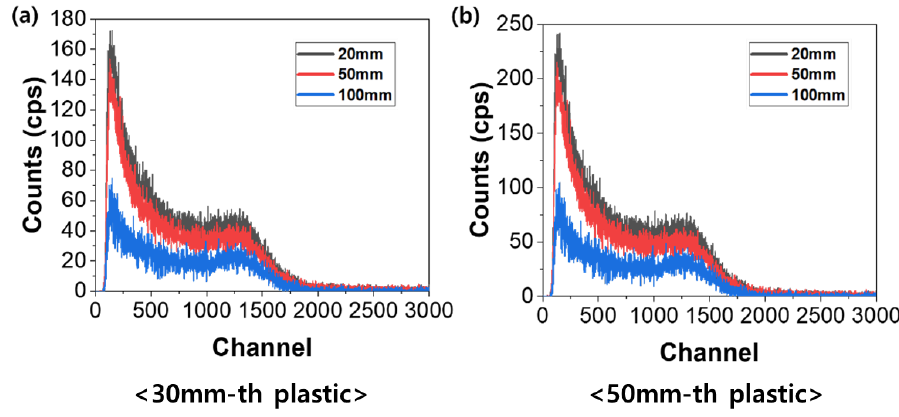
Figure 9. Measurement results due to the distance from the contaminated soil sample using a CdS/ZnS-loaded plastic scintillator: ( a ) 30 mm thickness in a plastic scintillator; ( b ) 50 mm thickness in a plastic scintillator.